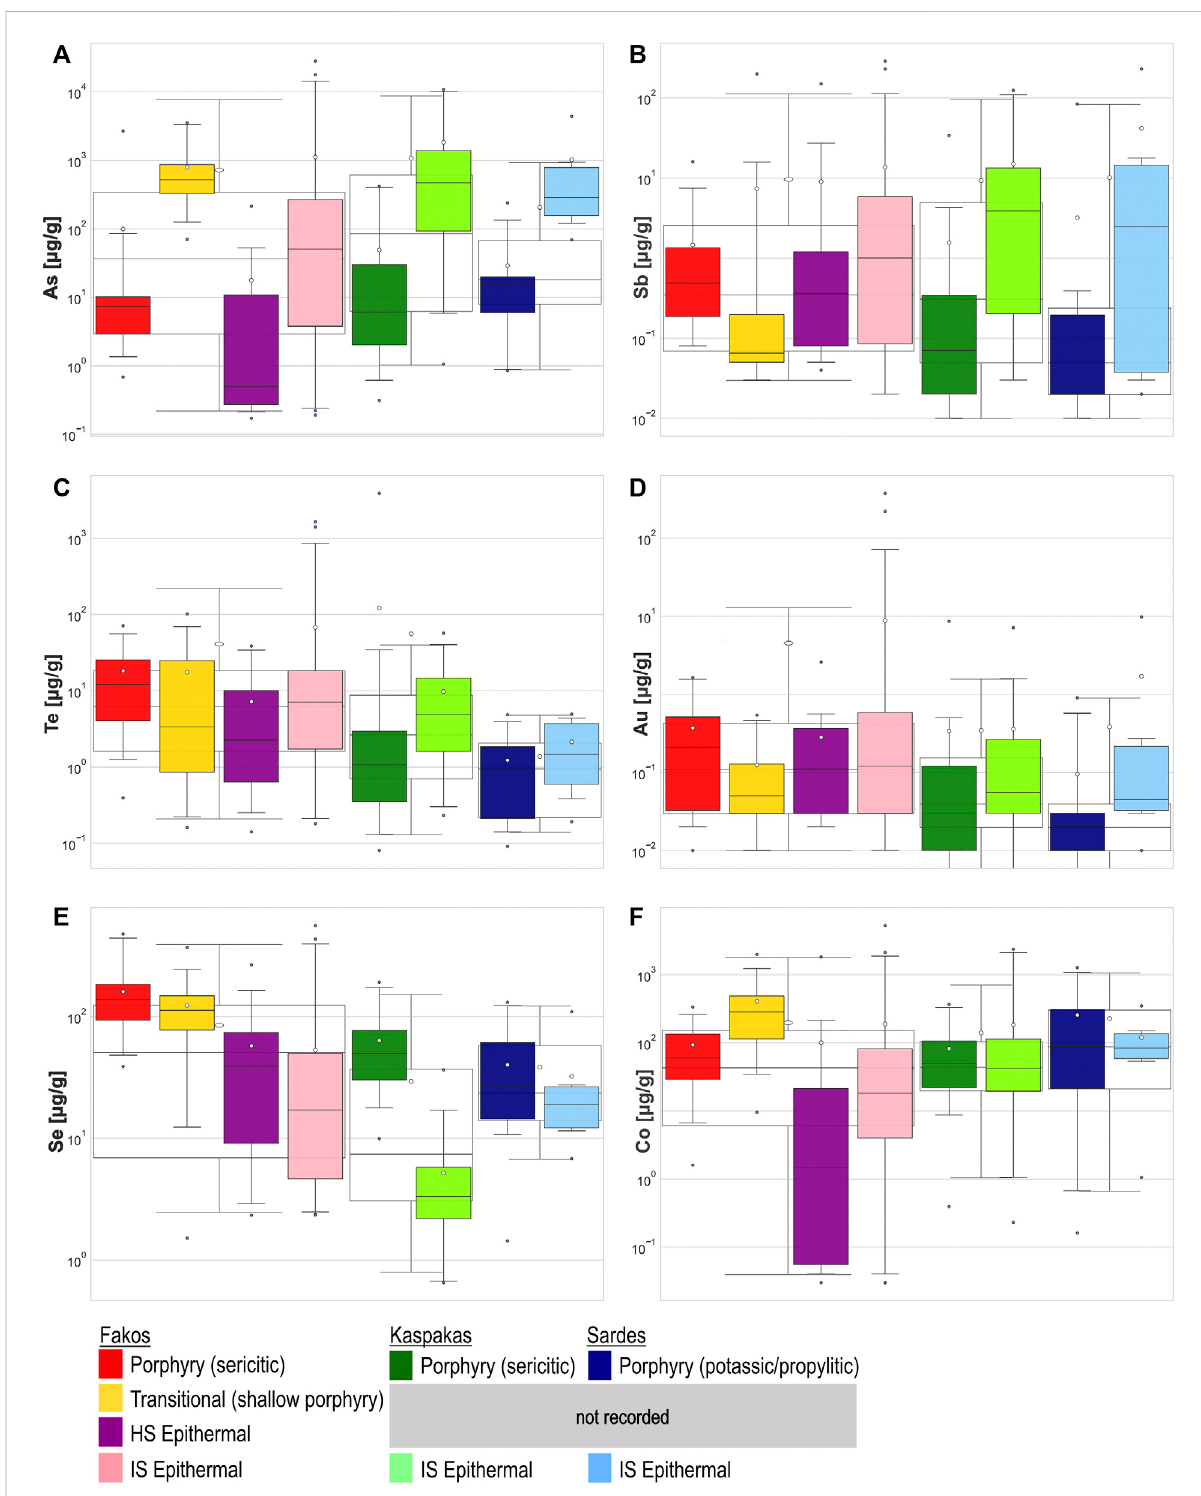
FIGURE 6 Boxand whisker plots oftrace elements inpyrite. (A) As; (B) Sb; (C) Te; (D) Au; (E) Se; (F) Co, each in μ g/g. Notethat thepresented data includes thedetectionlimitsoftheindividualanalyses.Theboxrepresents50%ofthedataandthewhiskersthe2ndand98thpercentile.Thehorizontallinein the box is the mean value and the cross the median value, which includes the outliers. The large black outlined box in the background summarizes the data of the different prospects irrespective of the related alteration/mineralization